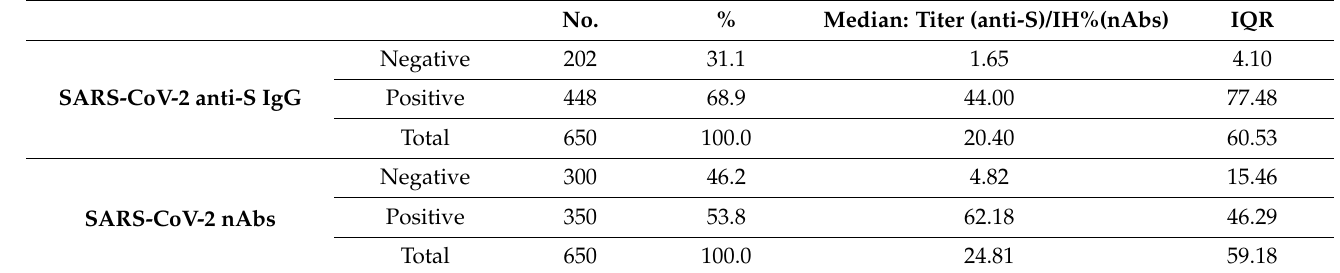
Table 1. Distribution of the 650 samples according to their median (IQR) results for SARS-CoV-2 anti-S IgG titer (RU/mL) and SARS-CoV-2 nAbs (%IH). No. % Median: Titer (anti-S)/IH%(nAbs) IQR No.